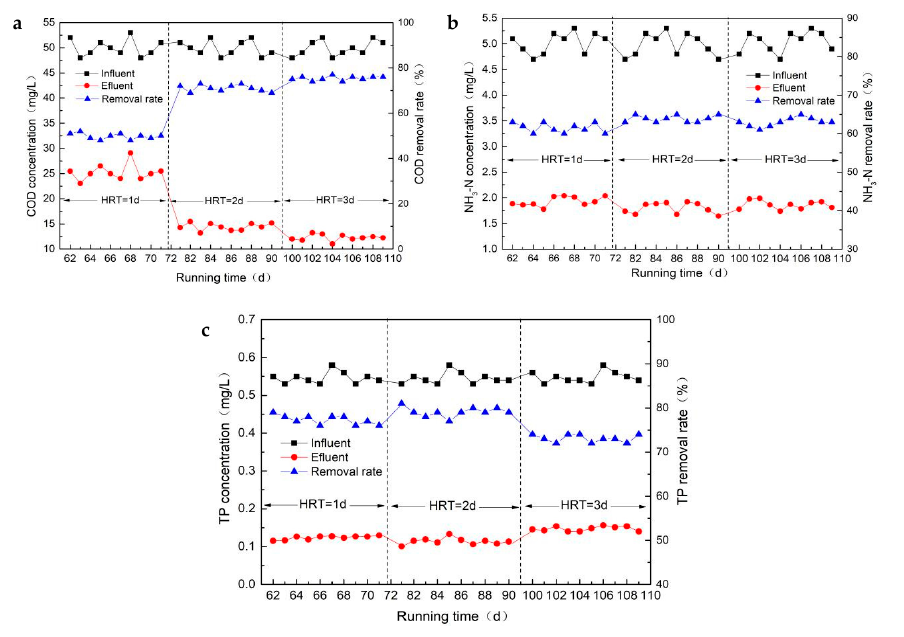
Figure 5. Chart of COD ( a ), NH 3 -N ( b ), and TP ( c ) removal under different hydraulic retention times (HRTs).